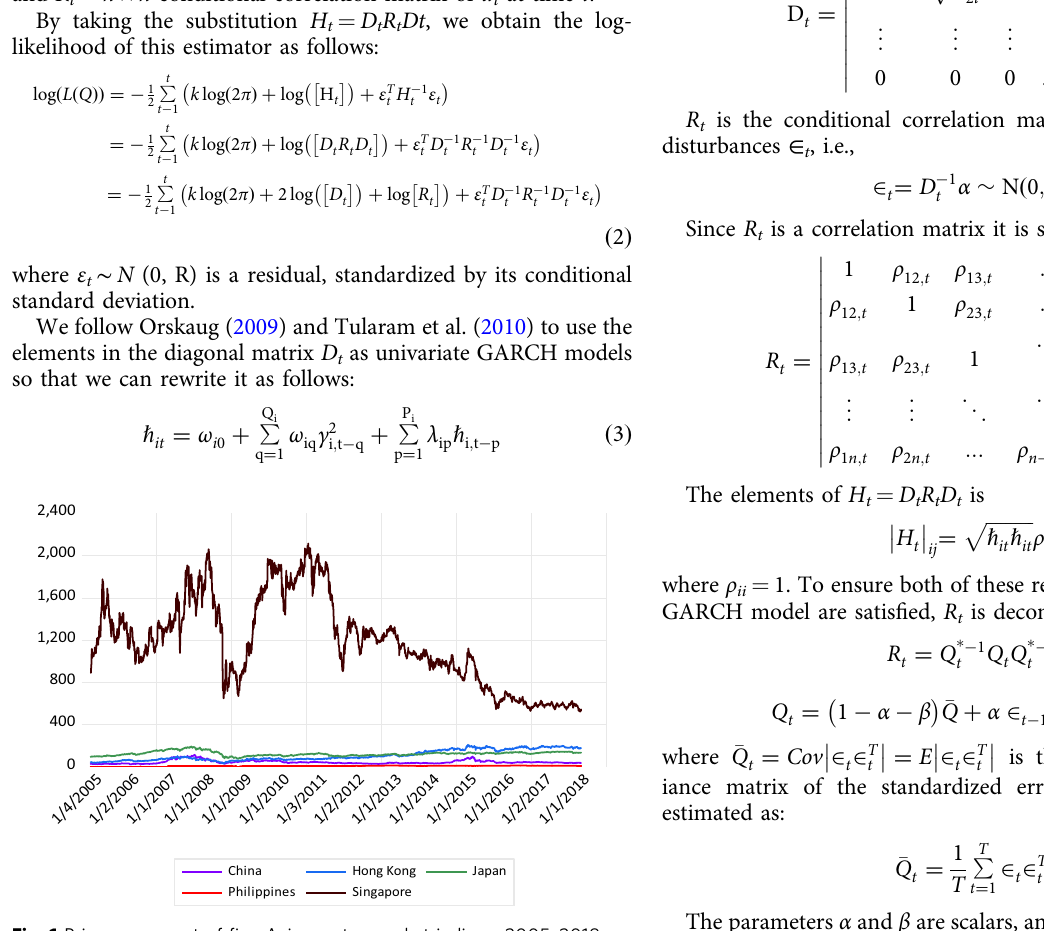
Fig. 1 Price movement of fi ve Asian water market indices, 2005 – 2018.